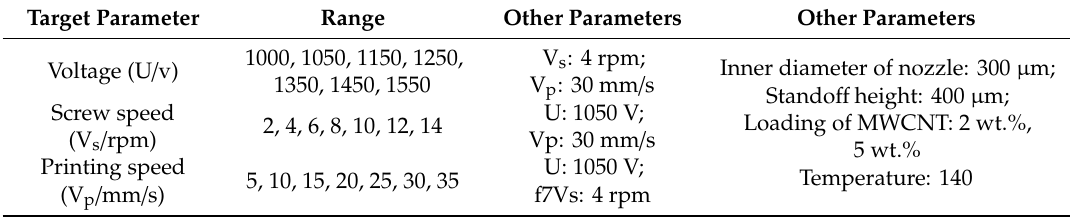
Table 1. Investigating parameter of EFD jetting 3D printing